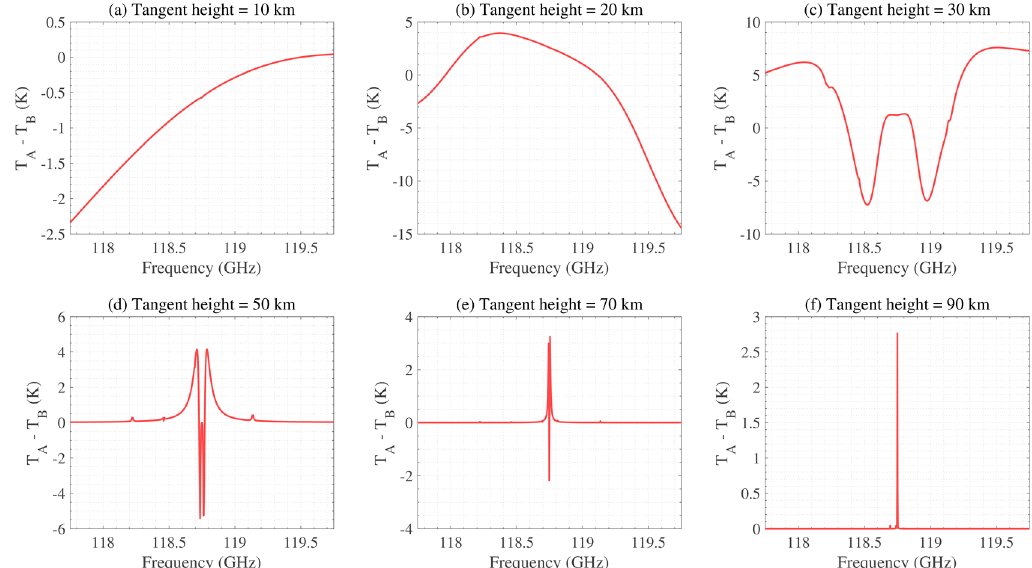
Figure 6. The brightness temperature difference 𝑇 (cid:3002) – 𝑇 (cid:3003) at various tangent height measured by the 118 GHz radiometer: ( a ) 10 km; ( b ) 20 km; ( c ) 30 km; ( d ) 50 km; ( e ) 70 km; ( f ) 90 km.